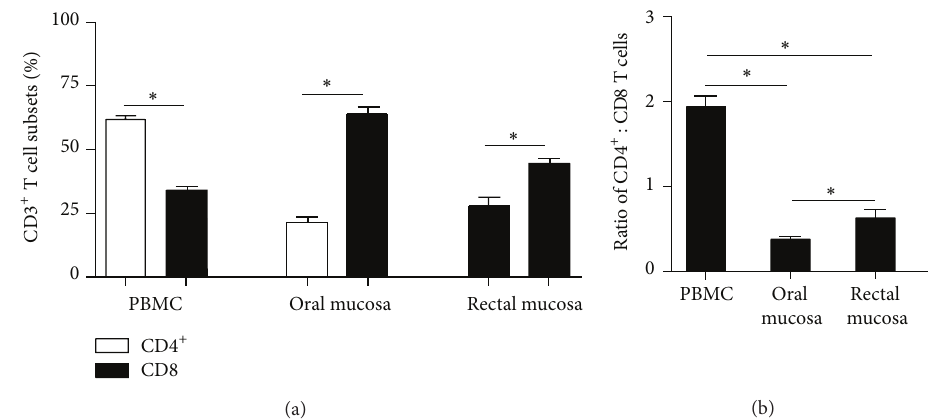
Figure 1: CD4 + T cells are a minor population of T cells in the oral mucosa of healthy animals. (a) The proportions of CD3 + CD4 + and CD3 + CD8 + T cells in peripheral blood and oral and rectal mucosa of healthy rhesus macaques. (b) The ratio of CD3 + CD4 + : CD3 + CD8 + T cells in peripheral blood and oral and rectal mucosa of healthy rhesus